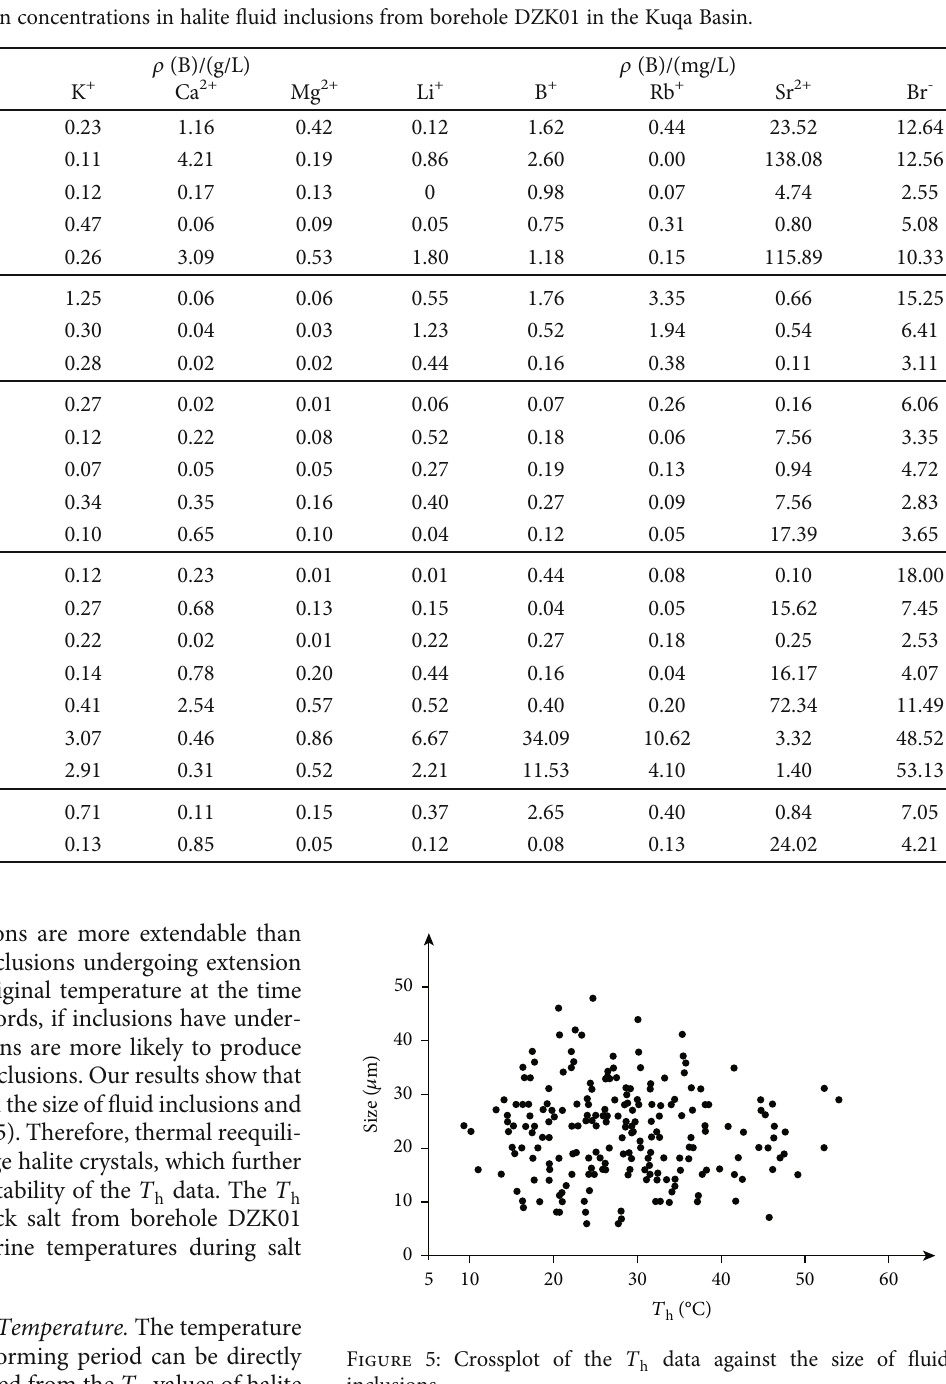
h data against the size of